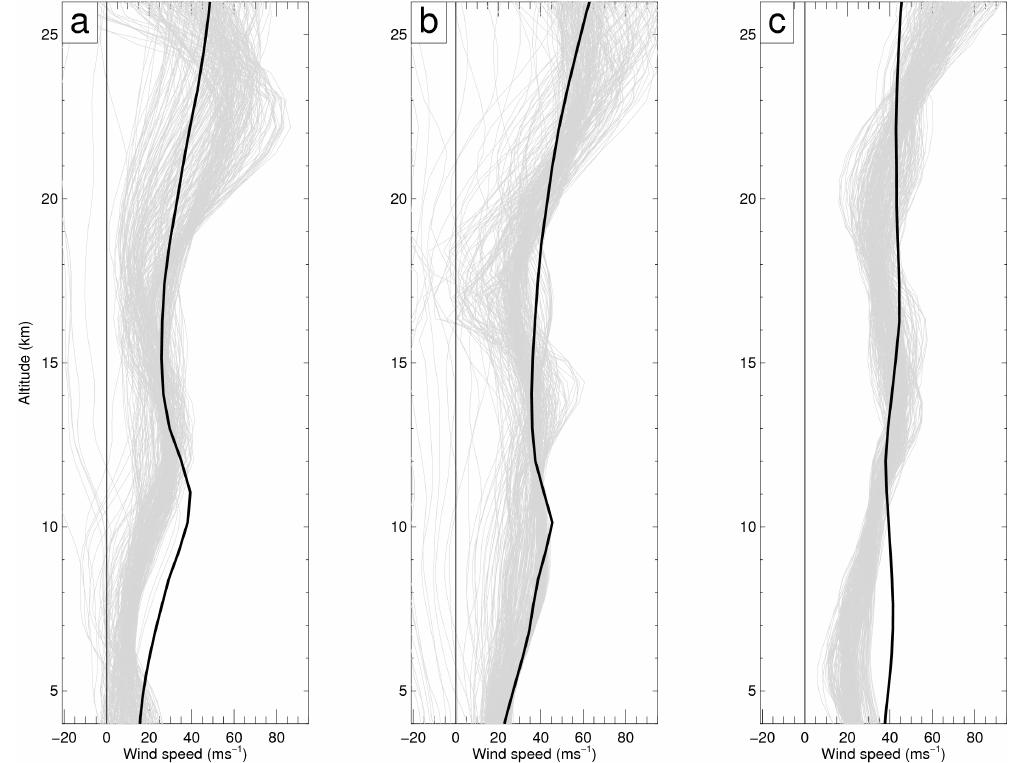
Figure 7. Vertical profile of the wind speed U (resolved in the direction of the wave vector, which is taken to be the direction of the 850hPa wind vector) simulated by the climate model (black line) and the mesoscale model (grey lines) at the time of the CS1 (a) , CS2 (b) , and CS3 (c) mountain wave events. See Table 1 for dates. The climate model profile is for the same grid box used for Fig. 5. The mesoscale model profiles are for all the mesoscale model points within the same climate model grid